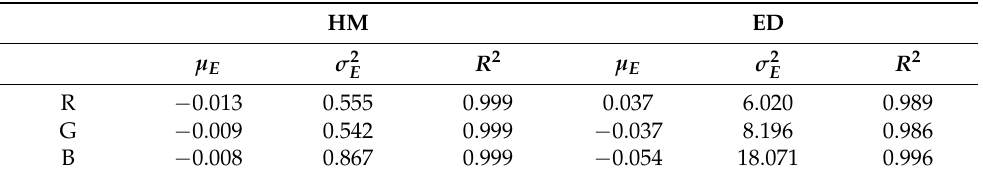
Table 2. Error characteristics of RGB self-validation tests with ( α , λ ) = ( 500,8 ) ; mean of intensity differences, variance of intensity differences, coefficient of determination.